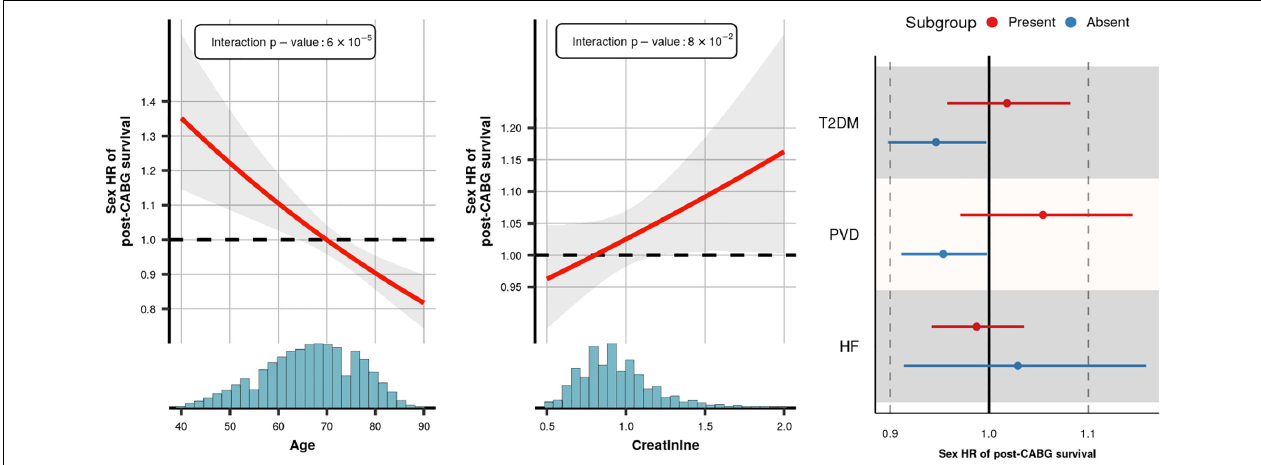
FIGURE 5 | Subgroup specific effects of female sex on post-CABG survival. x -axis histogram provides the sample age distribution. Presented hazard ratio curve is based on the imputed model and accounts for the variables reported in the footnote of Figure 3 . The interaction p -values for age and creatinine are provided in the illustration, for T2DM, PVD, and HF these were 0.07, 0.04, and 0.35, respectively. HR, hazard ratio; the interval and shaded area represent a 95% confidence